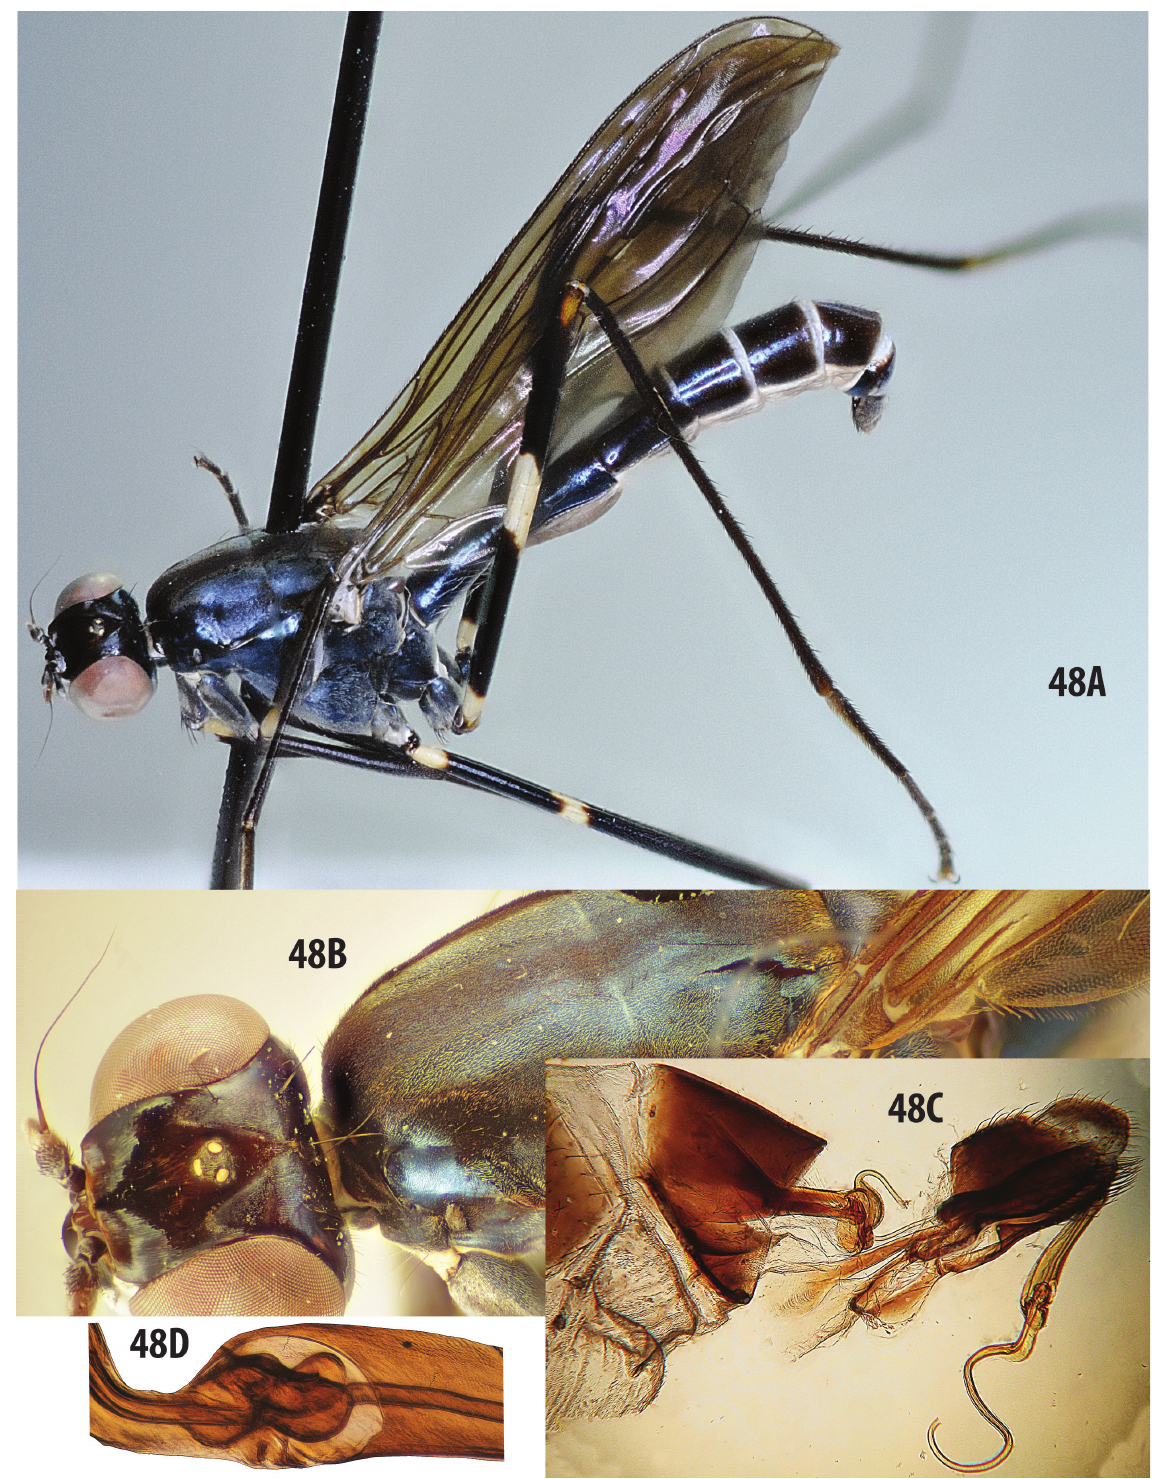
Fig. 48. Mesoconius rex sp. nov., holotype, ♂, IAVH. A . Habitus, dorsolateral view. B . Head and thorax, dorsolateral view. C . Apex of abdomen, with terminalia detatched (phallus teased out, ejaculatory duct broken). D . Phallic